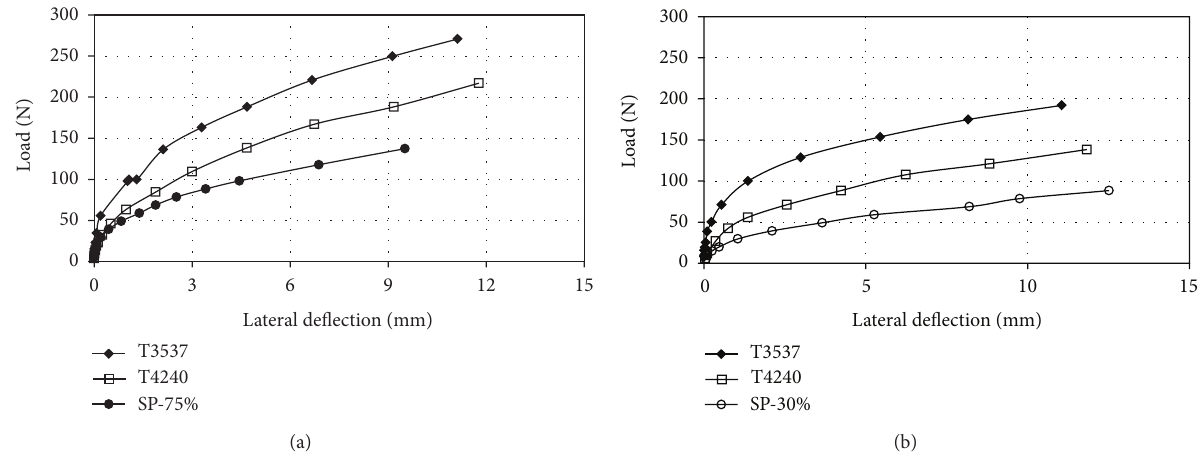
Figure 9: Lateral load versus lateral deflection for three-pile group in Parallel layout; (a) 𝐷 𝑟 =75% and (b) 𝐷 𝑟 =30%.